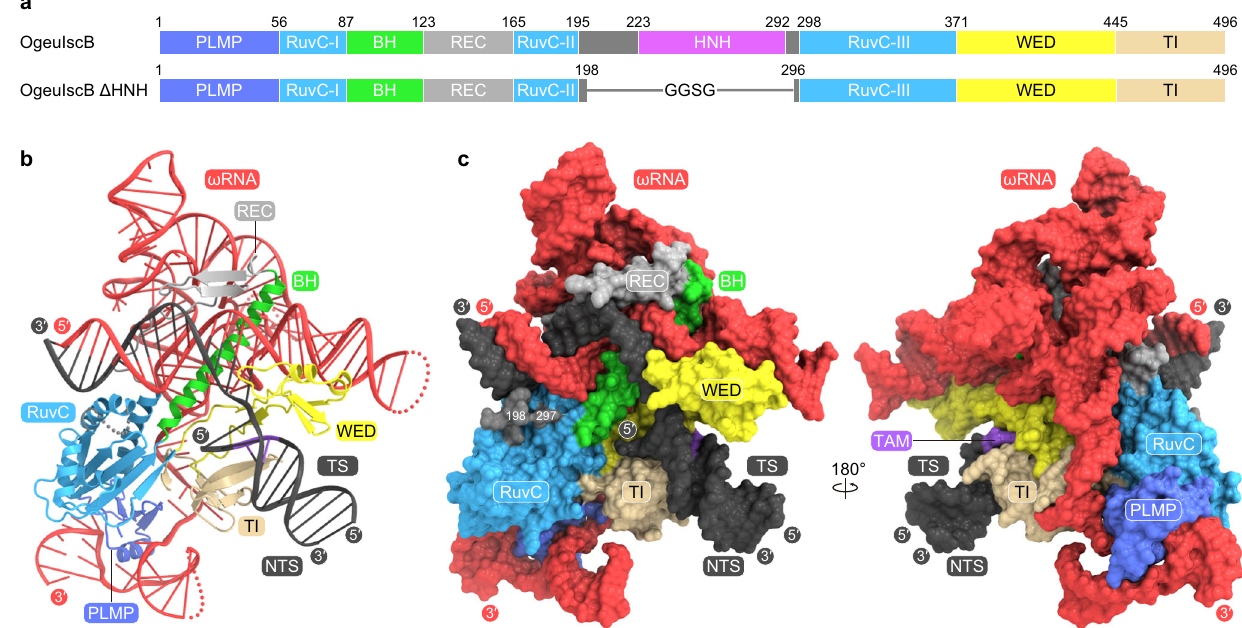
Fig.1|OverallstructureoftheIscB – ω RNA – targetDNAcomplex.a Domainstructuresofthewild-typeand Δ HNHmutantofOgeuIscB.BH,bridgehelix. b , c Ribbon( b ) and surface ( c ) representations of the IscB – ω RNA – target DNA complex. TS target DNA strand, NTS non-target DNA